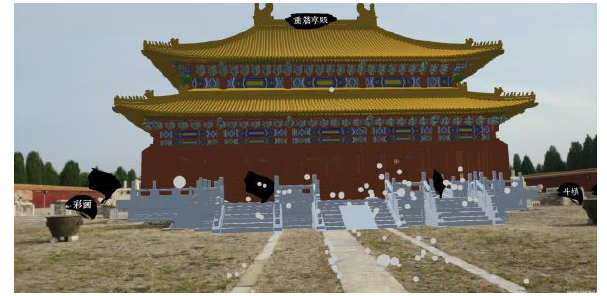
Figure 42. Reconstruction of Zhaoxi-ling